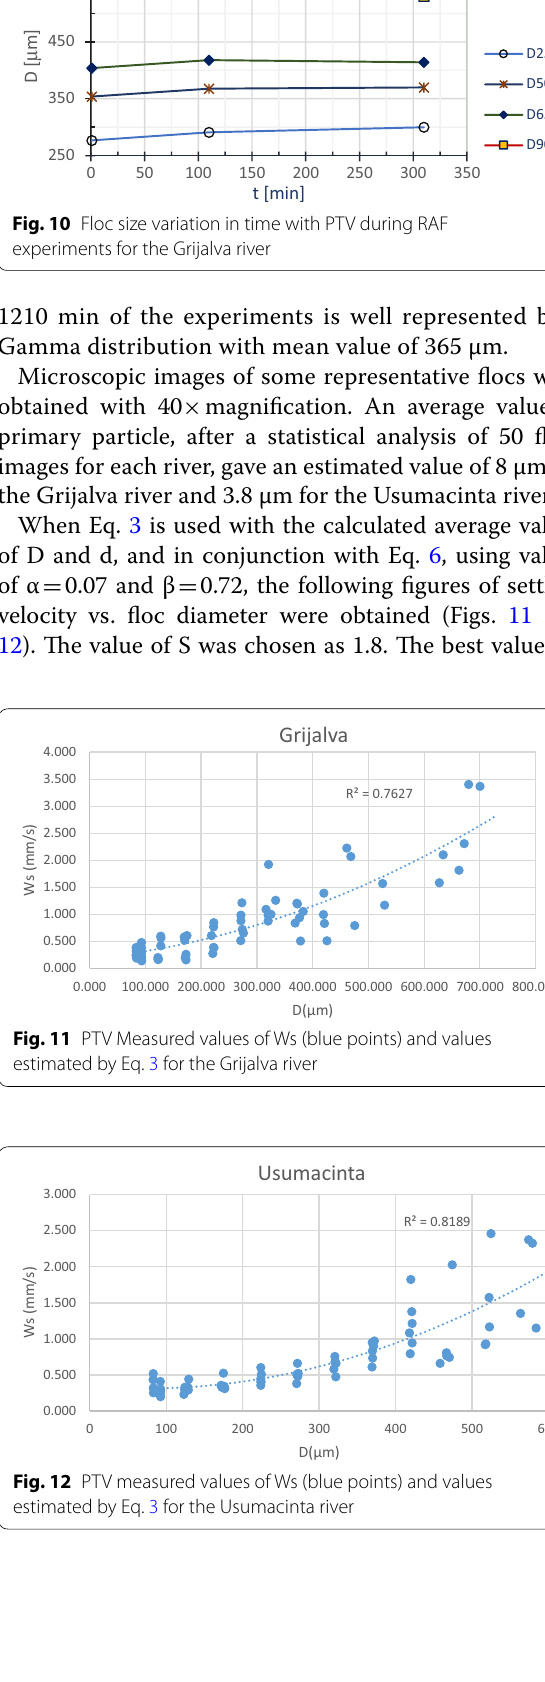
Fig. 12 PTV measured values of Ws (blue points) and values estimated by Eq. 3 for the Usumacinta river